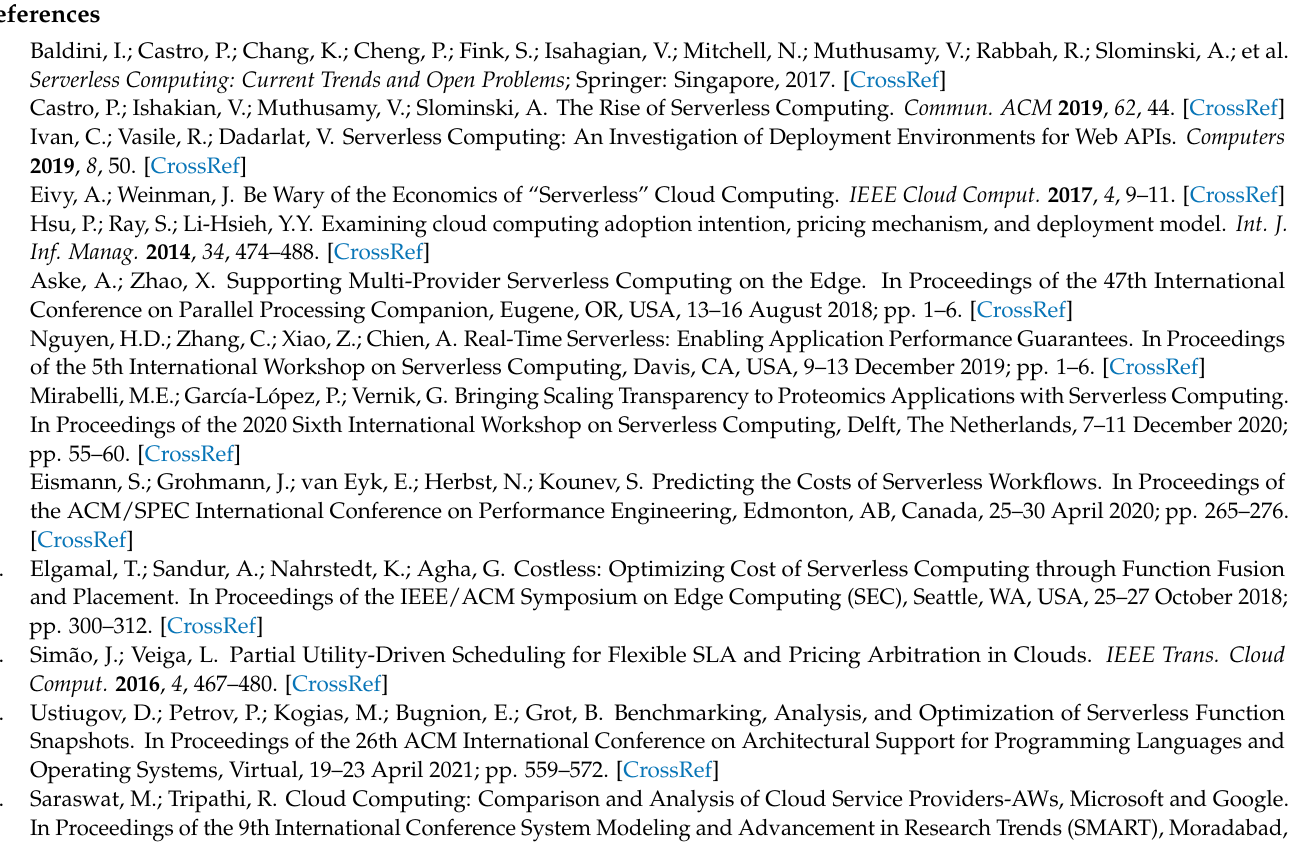
Figure A2. Cloud-agnostic function definition